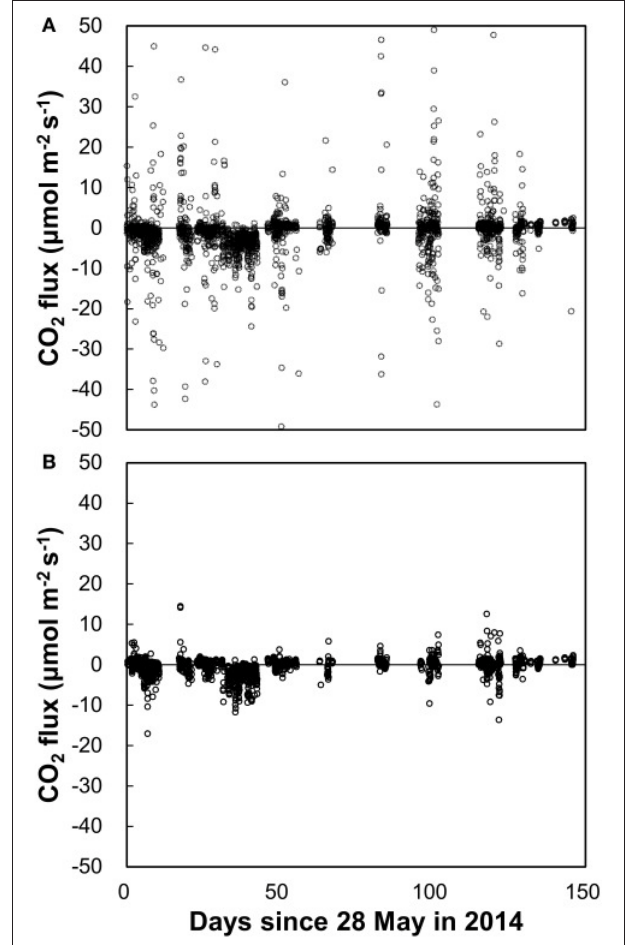
FIGURE 3 | EC CO 2 fluxes with (A) PP1 (mean: − 1.93 µ mol m − 2 s − 1 , SD: 52.4 µ mol m − 2 s − 1 , n = 2,502) and with (B) PP2 (mean: − 0.54 µ mol m −